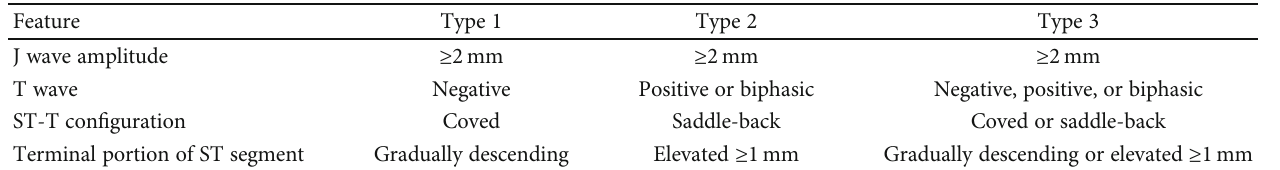
Table 1: Patterns of ST abnormalities in leads V1-V3.